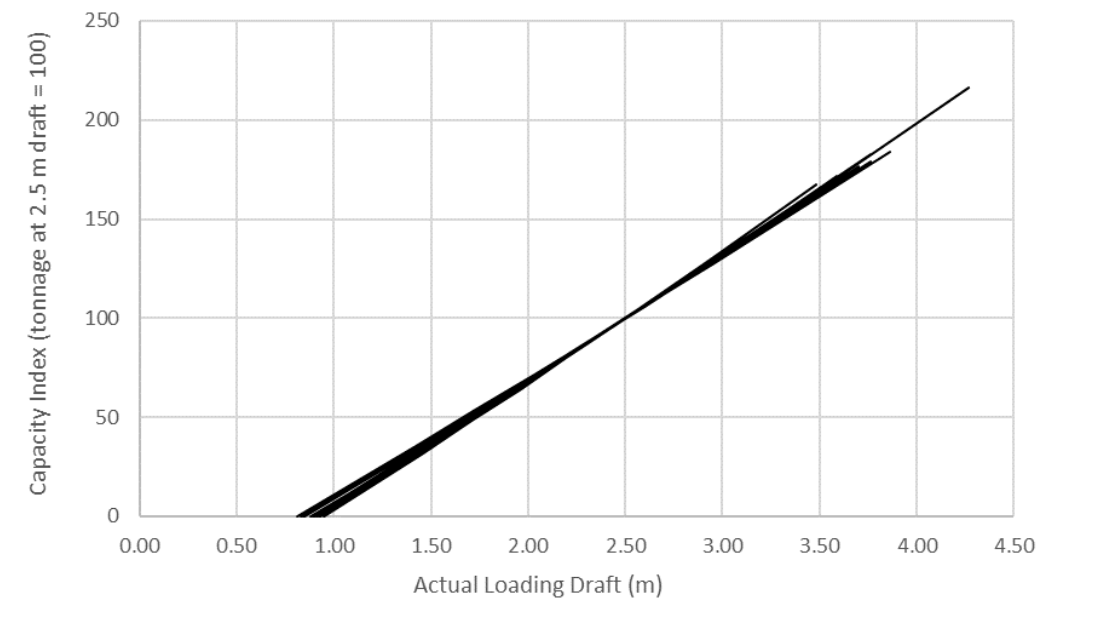
Figure 4. Capacity index at actual loading draft for 17 containerships in the dataset